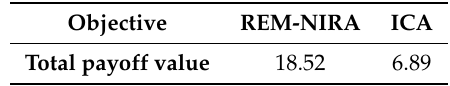
Table 1. Total payoff values of all players related to REM-NIRA and imperialist competition algorithm (ICA) under Scenario